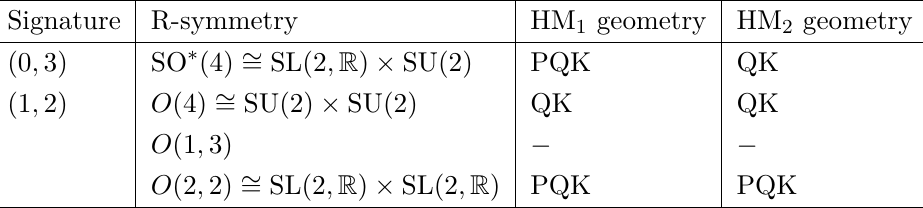
Table 2 . Three-dimensional N = 4 supersymmetry algebras, their R-symmetry groups and their scalar geometries. See section 2.3 for further explanations.